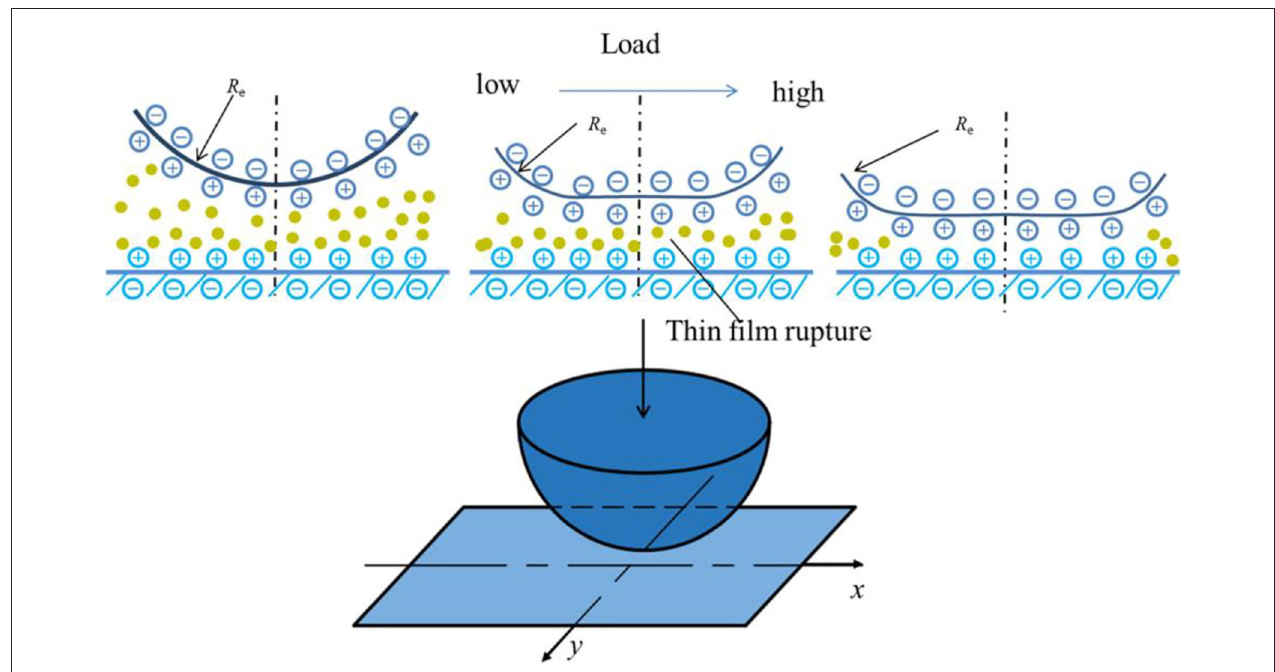
FIGURE 1 | Hydration-lubricated contact and its rupture under increasing load.